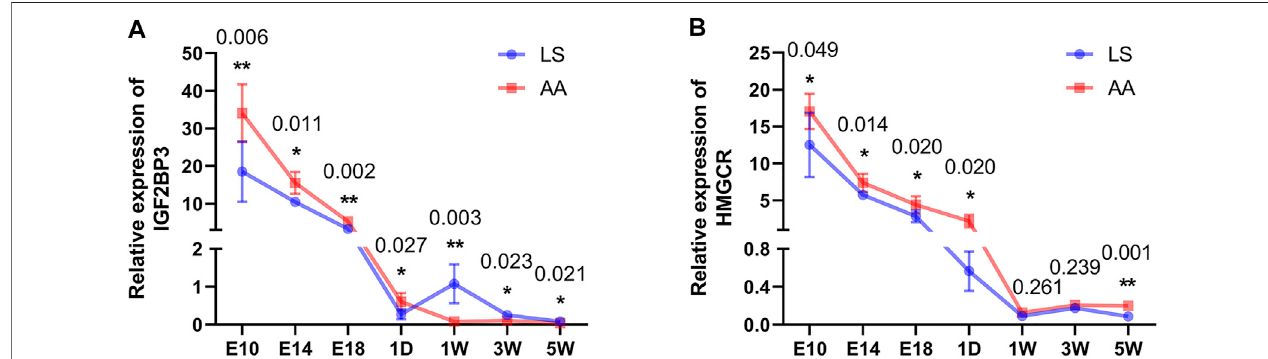
FIGURE 7 | Validation of mRNA expression of IGF2BP3 and HMGCR candidates in breast muscles from AA and LS chicken by qRT-PCR. (A) IGF2BP3 mRNA expression in breast muscles from AA and LS chicken by qRT-PCR. (B) HMGCR mRNA expression in breast muscles from AA and LS chicken by qRT-PCR. The numbers over each comparison indicate p